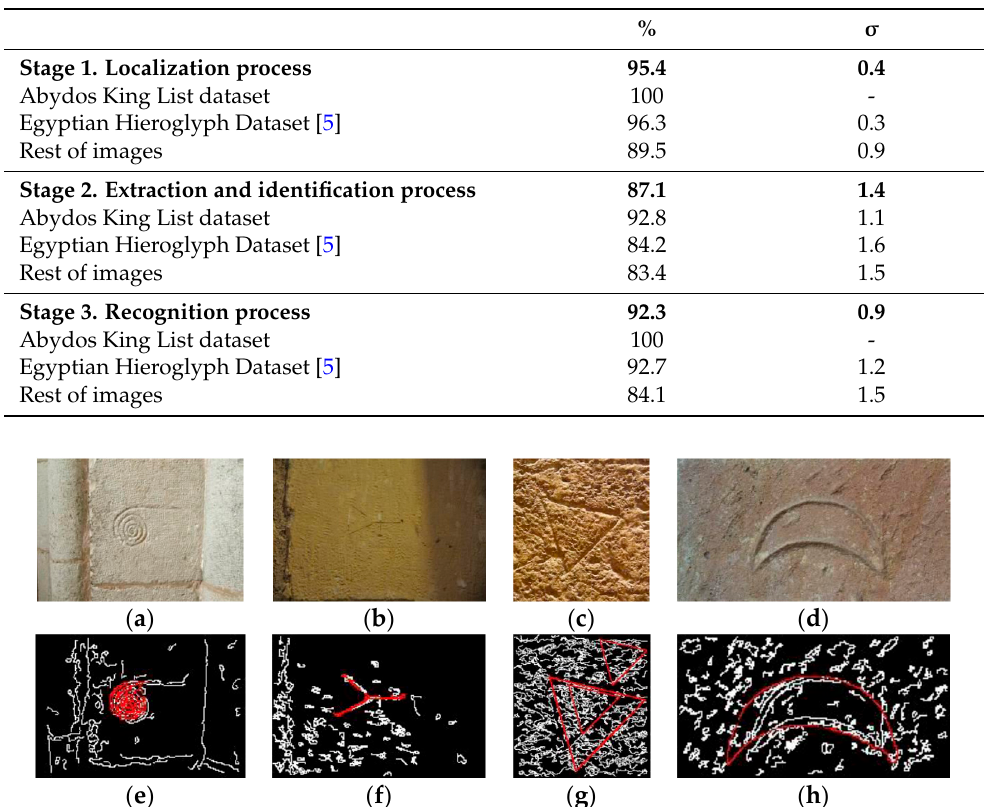
Table 4. Average rate of success and standard deviations obtained through the proposed three-stage method.